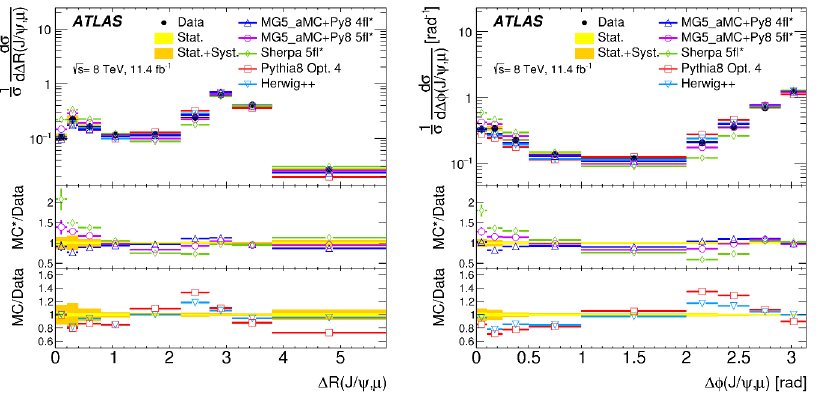
Figure 2: Measured normalised di ff erential cross sections as a function of ∆ R ( J /ψ, µ ) ∆ φ ( J /ψ, µ ).